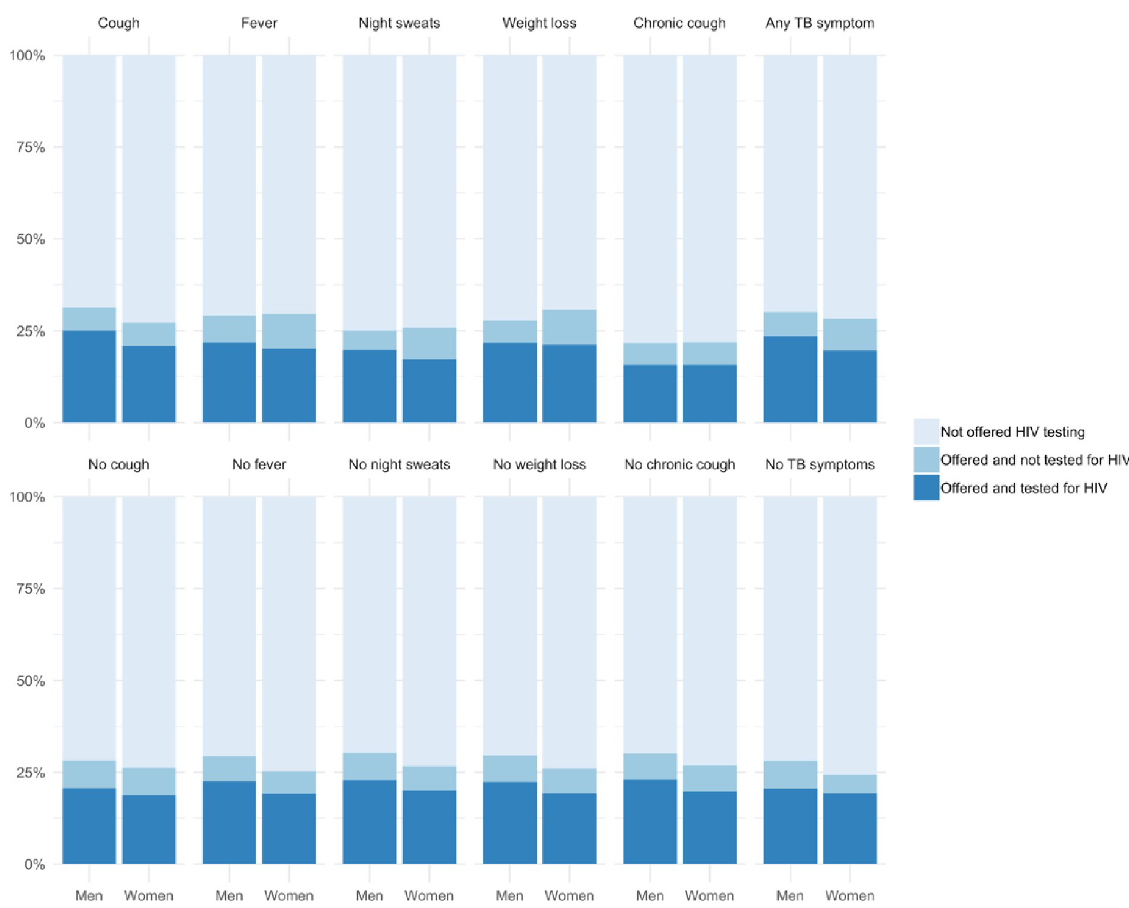
Fig 1. Percentages of participants offered and completing HIV testing by TB symptoms. Proportions of patients offered HIV testing. Stratified by those with TB symptoms (top row) and those without TB symptoms (bottom row).